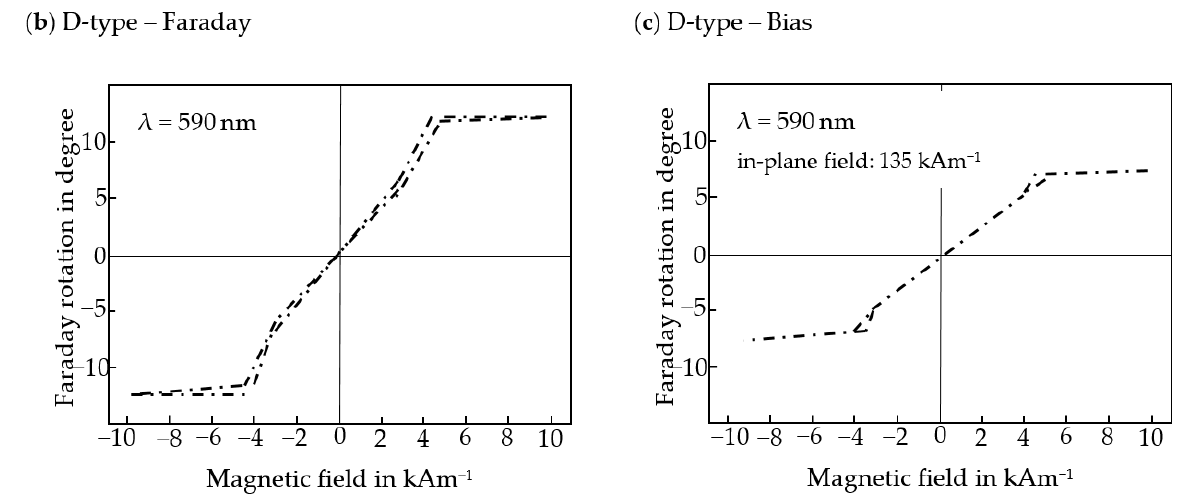
Figure 9. Parameters and approximate curves of characteristics-utilized MO-sensor; ( a ) A-type sensor: plot of magnetic field vs. Faraday rotation Φ ( λ = 590 nm), and selected parameters of the sensor; ( b ) D-type Faraday version of the sensor: plot of magnetic field vs. Faraday rotation Φ ( λ = 590 nm); ( c ) D-type bias version of the sensor: plot of magnetic field vs. Faraday rotation Φ ( λ = 590 nm). (Based on materials received from the manufacturer Matesy).